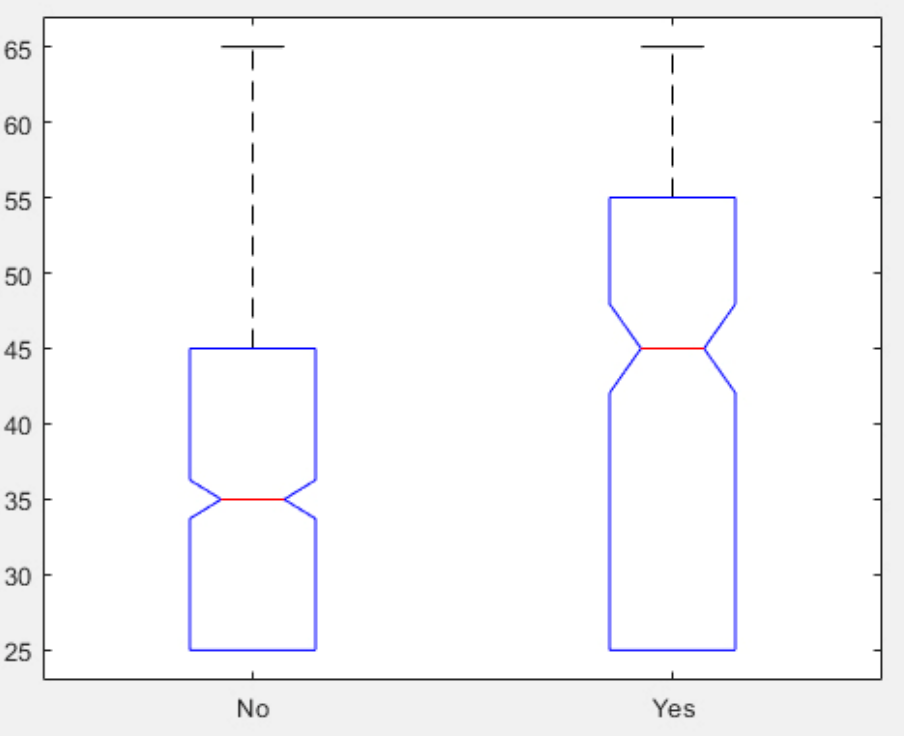
Figure 2. Median age of nurses that use (Yes) and do not use (NO) websites.